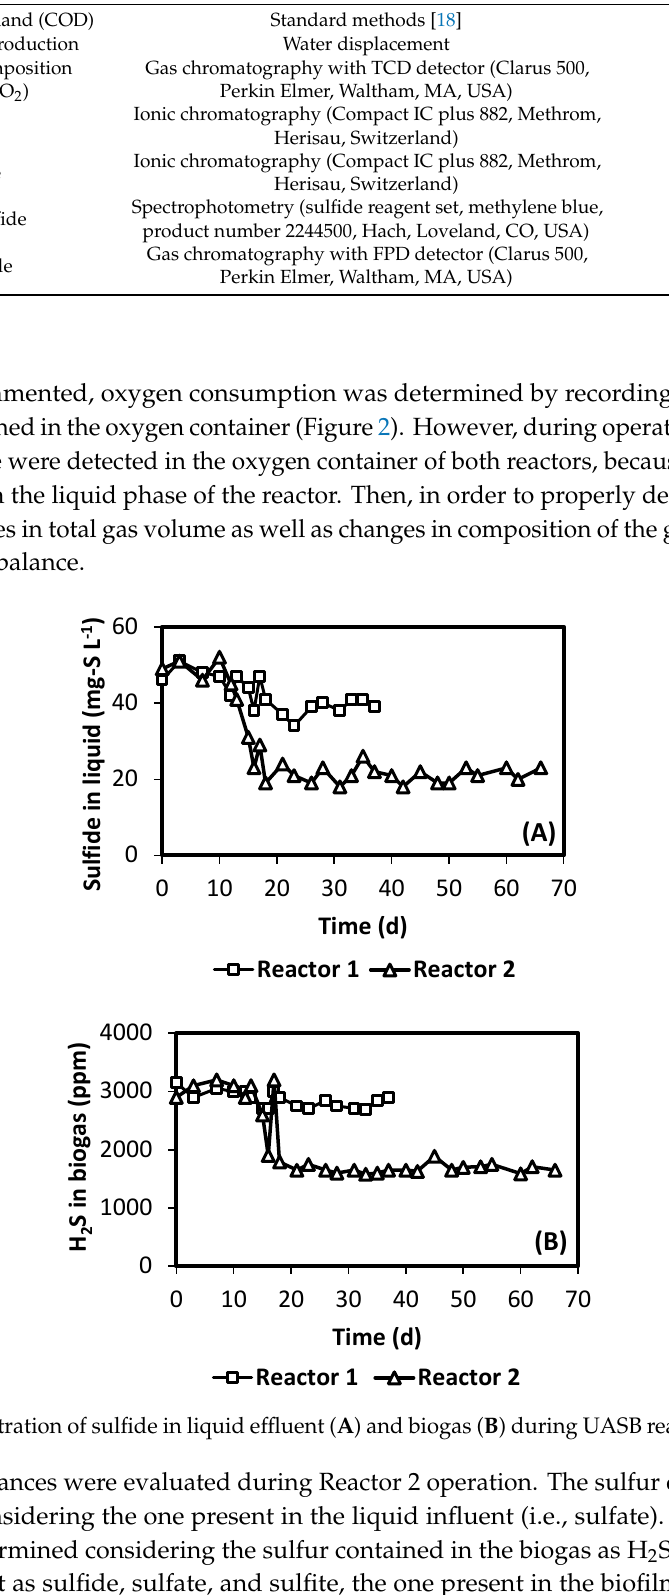
Table 1. Parameters determined during system operation.